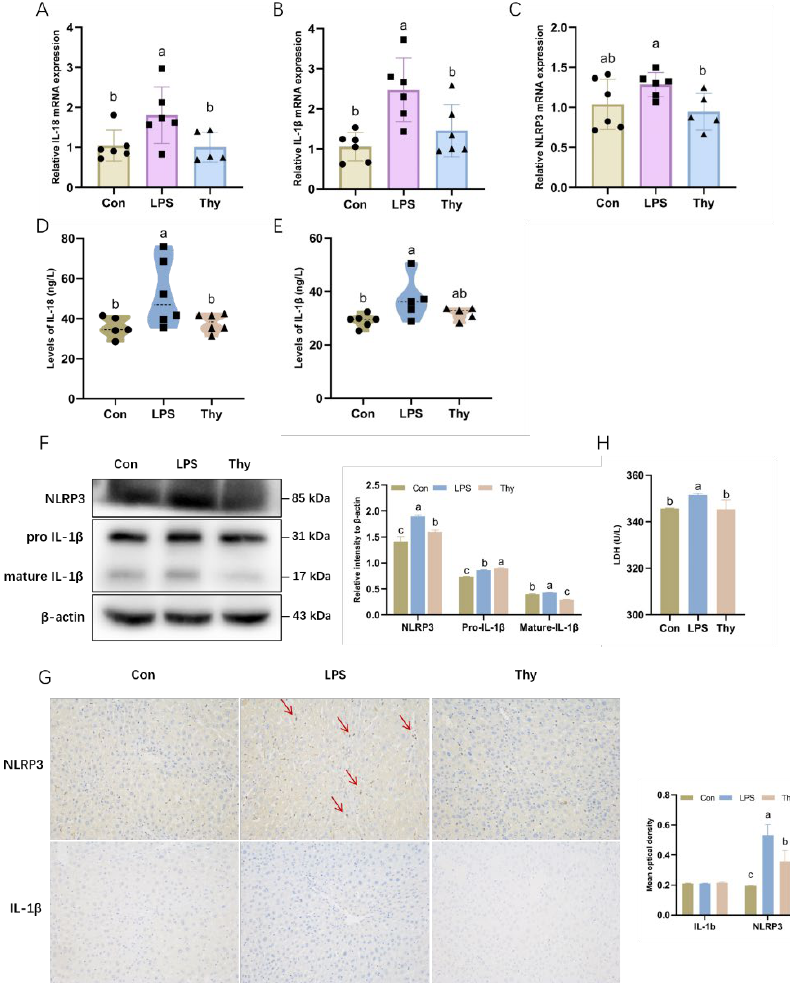
Figure 3. Tryptophan inhibits the NLRP3 inflammasome to defend against inflammation. The mRNA expression of ( A ) IL-18; ( B ) IL- 1β ; and ( C ) NLRP3 in the liver ( n = 5–6). The concentration of ( D ) IL-18 and ( E ) IL- 1β in the liver as examined by ELISA analysis ( n = 5–6); ( F ) The expression and quantification of NLRP3 and IL- 1β in liver as determined by Western blotting. Values are normalized to β -actin levels and expressed as the mean ± SD ( n = 6); ( G ) Immunohistochemistry of NLRP3 and IL- 1β in the liver (200 × magnification). The mean optical density of immunohistochemistry. Values are expressed as the mean ± SD ( n = 3); ( H ) The activity of LDH in primary hepatocytes ( n = 3). Con, control; Thy, thymol. Differences were presented with different superscript letters ( p < 0.05).